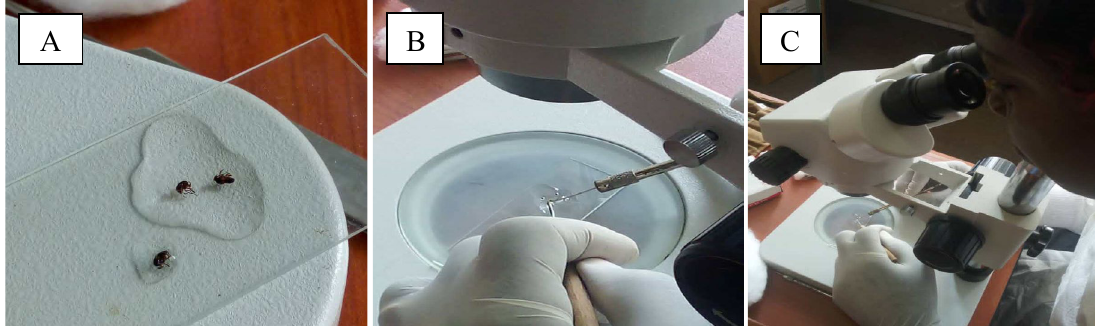
Figure 1. Anesthetized blackflies in normal saline(A), the dissection (B), and the study of dissected blackflies